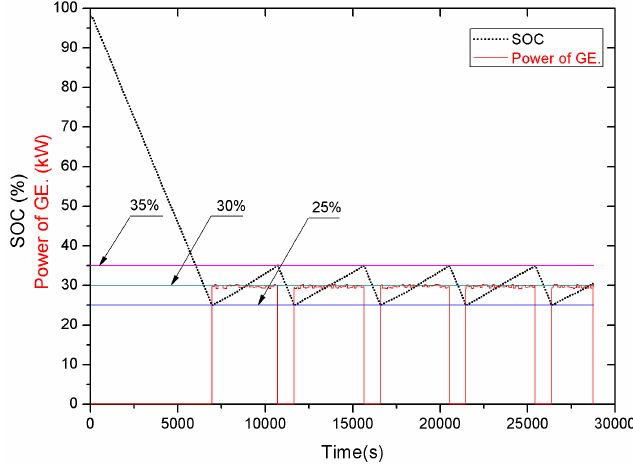
Figure 7. Batteries’ SOC and power of generator profiles for